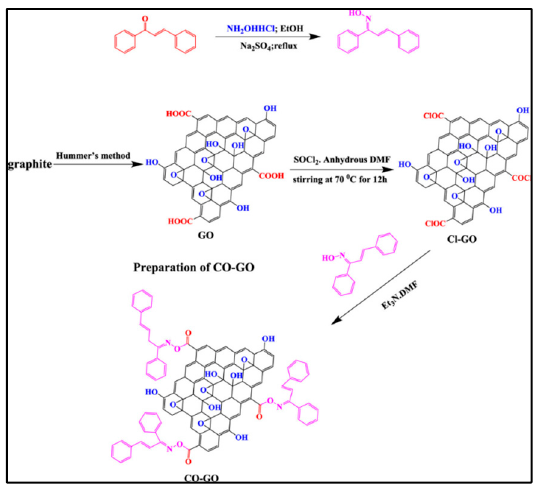
Figure 5. Scheme for the synthesis of chalcone oxime (CO)-functionalized graphene oxide. Re- printed with permission from [72] 2022 ACS Publ. with permission from [72] 2022 ACS